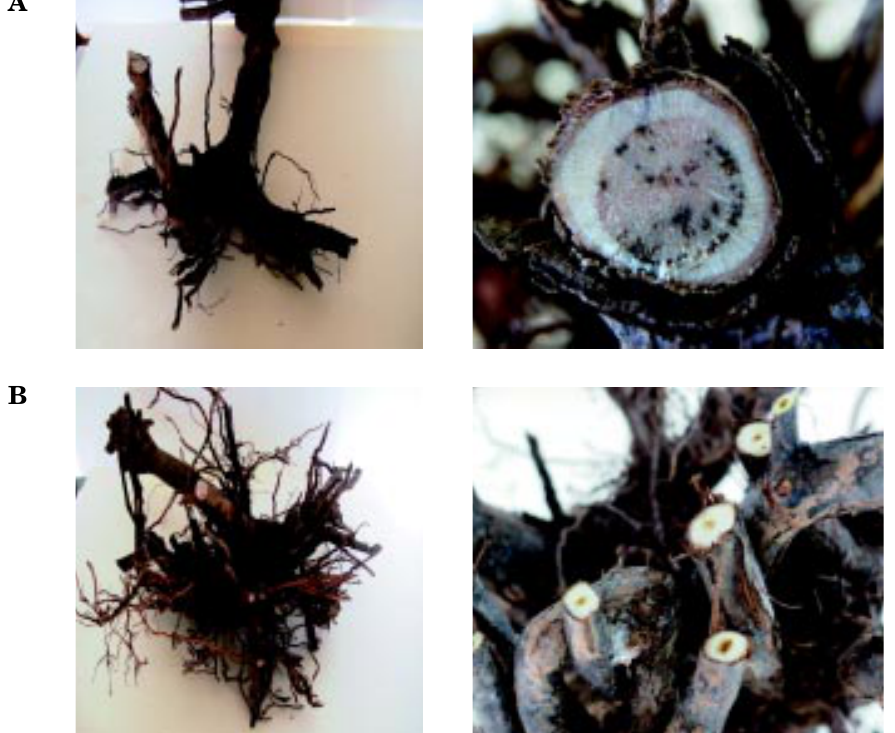
Fig. 6. Effect of Brotomax treatment on root development of a SO4 vine with Petri disease. A. Detail of a root cross- section in a control vine. B. Detail of roots and regenerated stems in vines treated with 0.3%